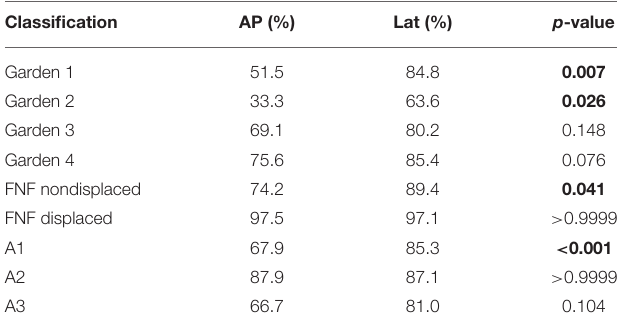
TABLE 2 | Percentage of correct diagnosis for proximal femoral fractures depending on AP view (AP) or ap and lateral view